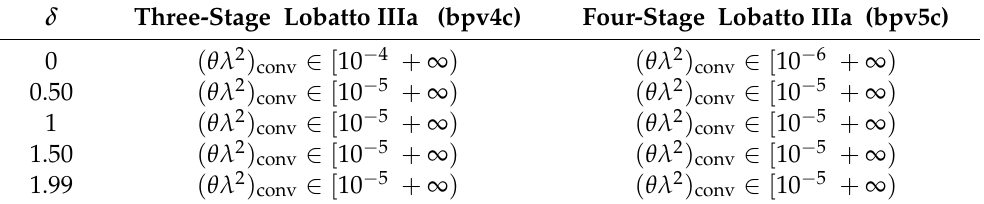
Table 2. Ranges of θλ 2 ensuring convergence (Three-/Four-Stage Lobatto IIIa).